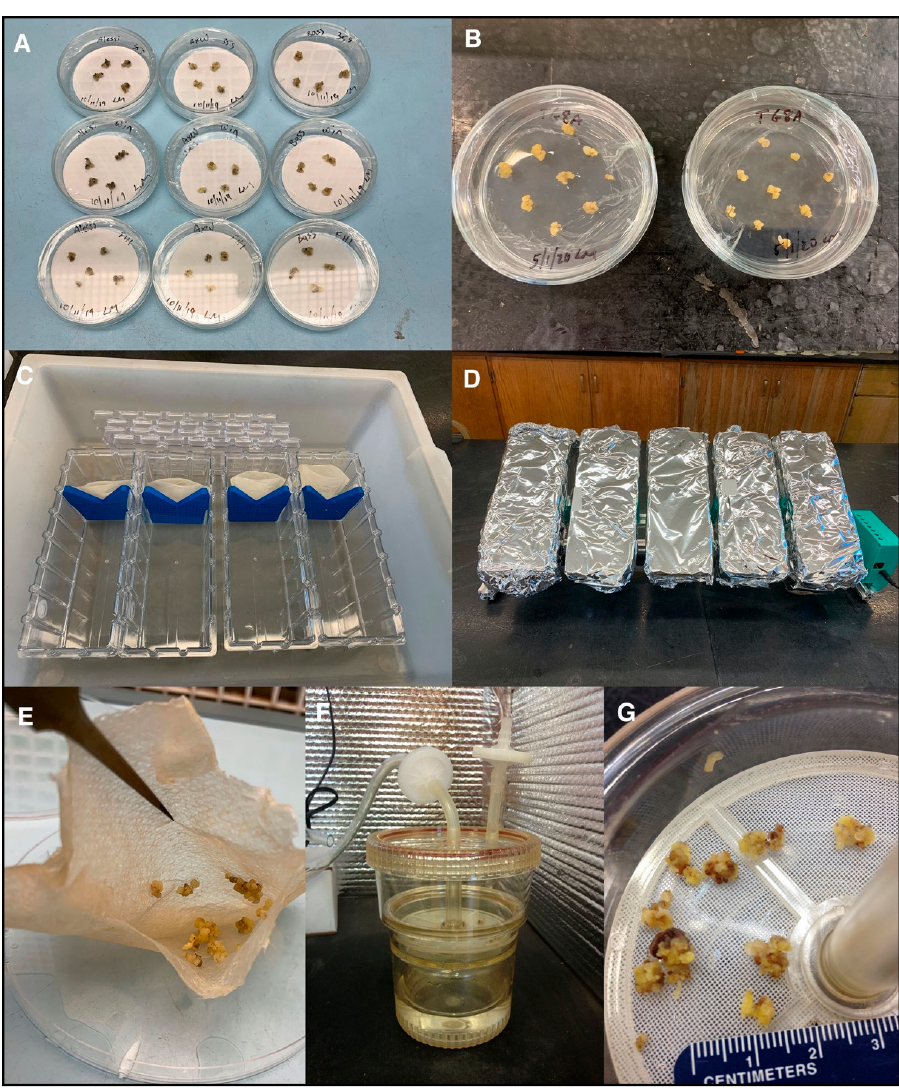
Figure 2. American chestnut somatic embryos during the transformation process. ( A ) Somatic ondesiccationplates. ( B )SelectionofembryoclumpsonsemisolidmediuminPetriplates.( C – E )Selection embryos on desiccation plates. ( B ) Selection of embryo clumps on semisolid medium in Petri plates. ( C – E ) Selection of embryo clumps in We Vitro containers with liquid medium. ( D ) Aluminum foil containers. ( E ) A tea bag is used to keep the embryo clumps from moving into the liquid covers the We Vitro containers. ( E ) A tea bag is used to keep the embryo clumps from moving into